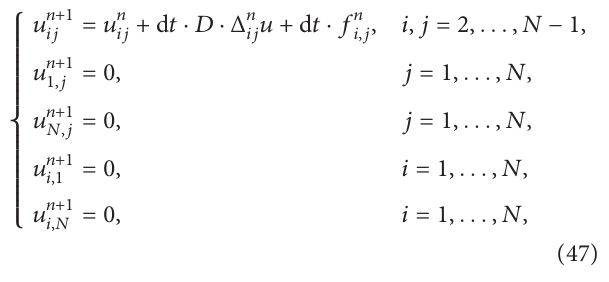
Figure 11: Evolution of the error with several values of N (d) The error for N r � 200.